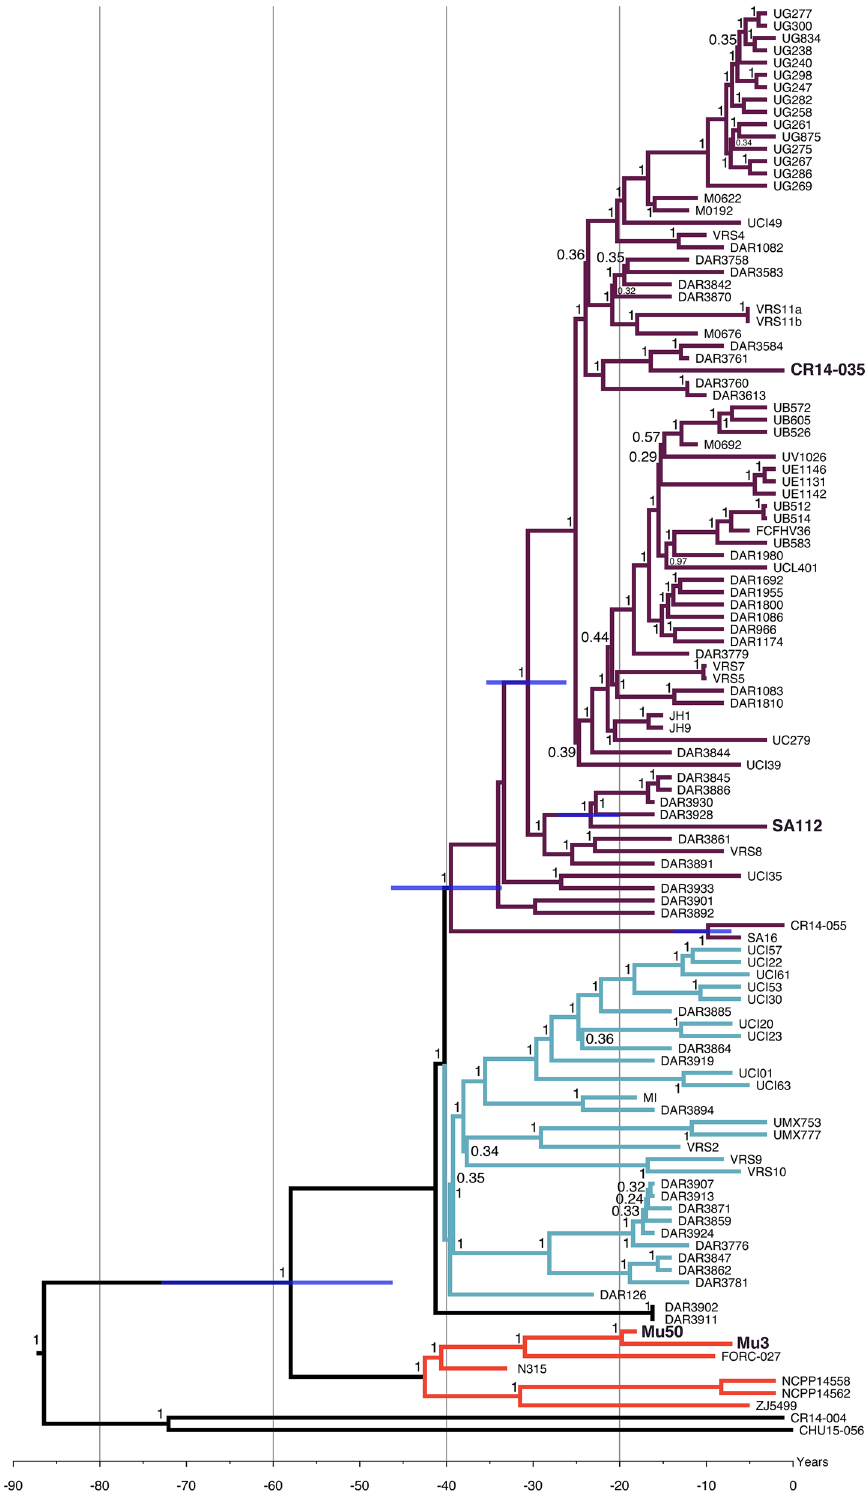
Figure 2. A time-calibrated Bayesian phylogeny for MRSA strains of the lineage ST5-SCC mec II from canine (SA112) and human origins obtained from 116 core genome alignments. Values at nodes indicate the posterior probabilities for each node. The tree is drawn to a time-scale indicated in years. Blue bars indicate the 95% credibility intervals (CI) for some node ages. The 95% CI for all nodes can be seen at Supplementary Figure S1. The year of 2015 was used as a reference point for chronological estimates, which corresponds to the isolation year of the most recent strain used for the tree